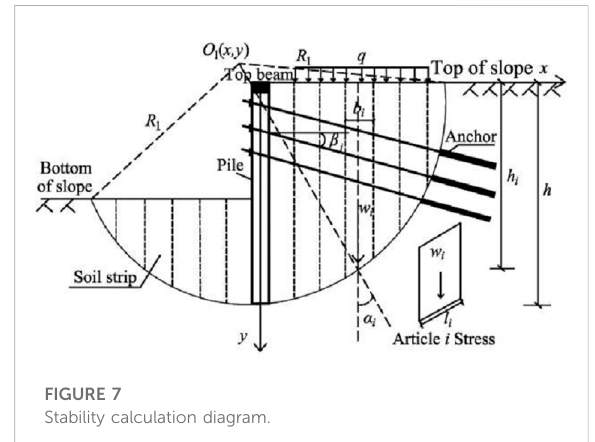
FIGURE 7 Stability calculation